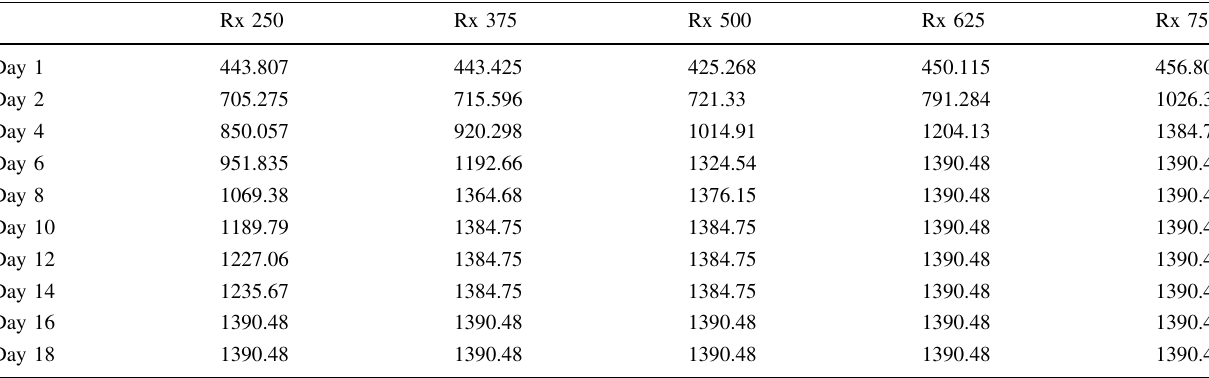
Table 7 Drainage radius in every correlation